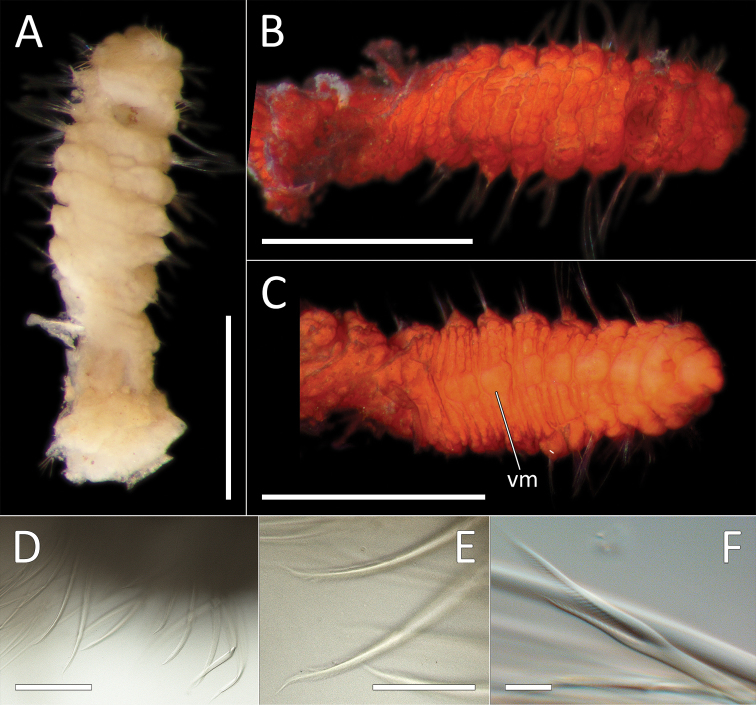
Scalibregmatidae sp. NHM_2308 (specimen NHM_2308). A Lab image, whole specimen, dorsal view (pre-stain) B Lab image, dorsal anterior (stained) C Lab image, ventral anterior, (shirla stained, vm = ventral midline) D Lab image, detail of hirsute spines on chaetigers 1 and 2 E Lab image, detail of hirsute spine tips F Lab image, detail of lyrate chaeta. Scale bars: 1 mm (A–C); 100 μm (D); 50 μm (E); 10 μm (F).